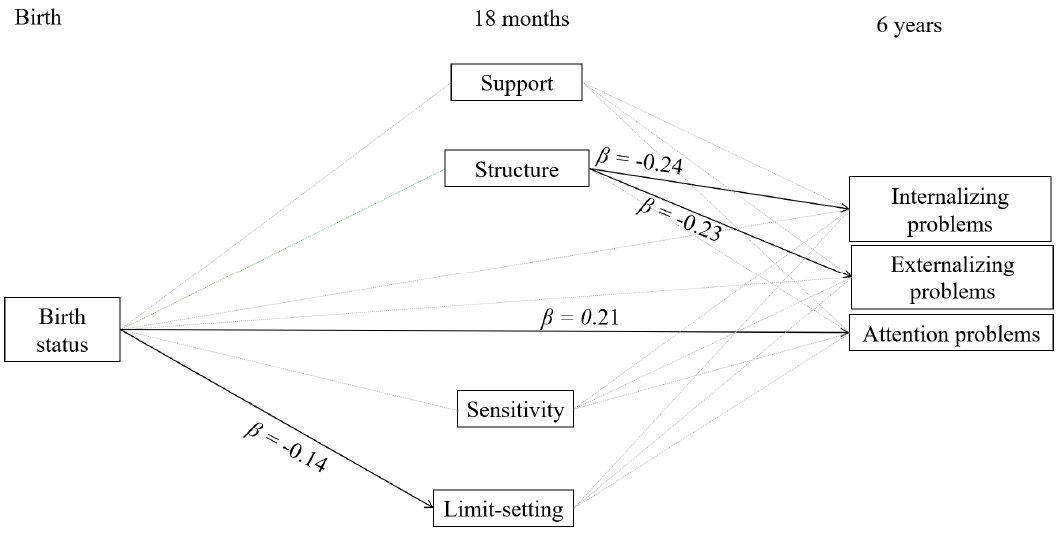
Figure 2. Model results. Bold lines represent significant paths. Birth status: 0 = full term, 1 = moderately preterm.